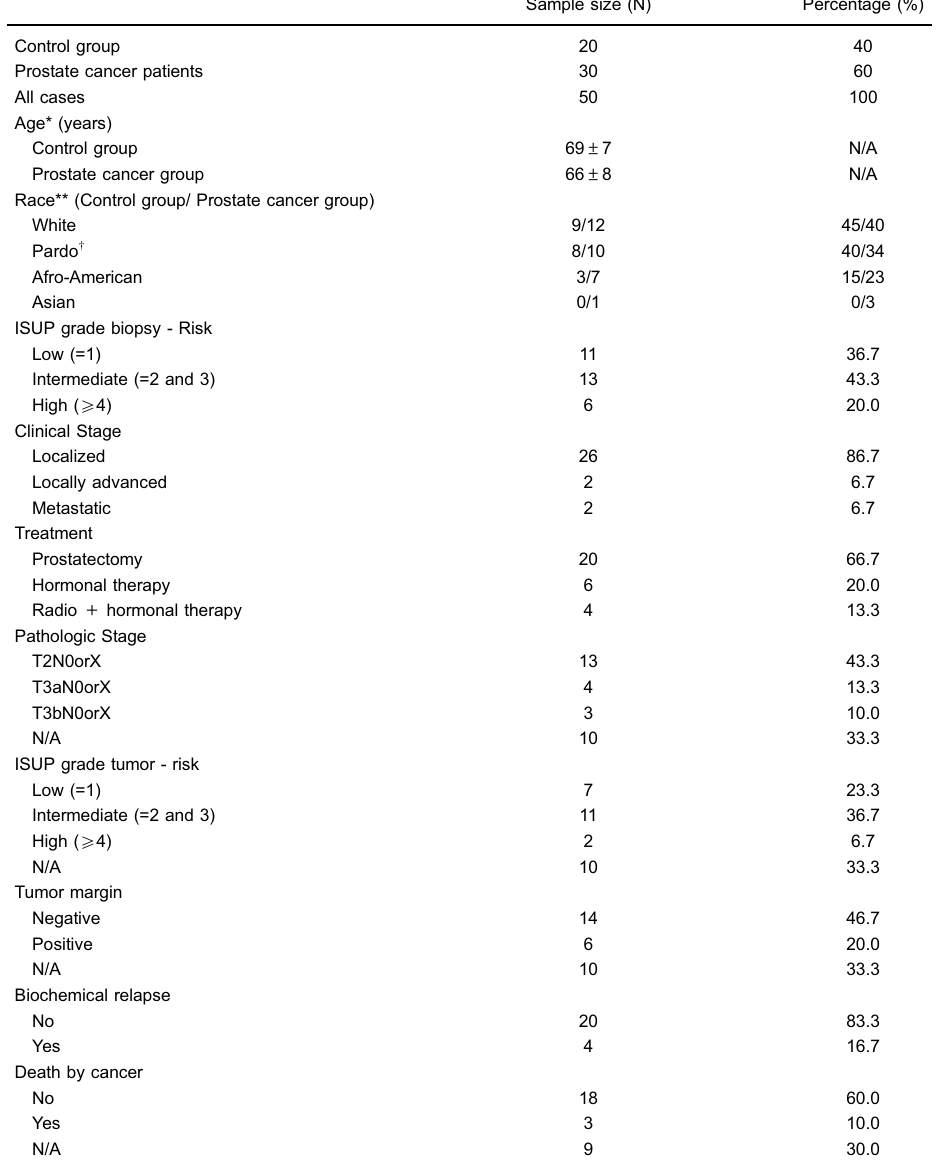
Table 1. The relative and the absolute number of patients by clinical-pathological